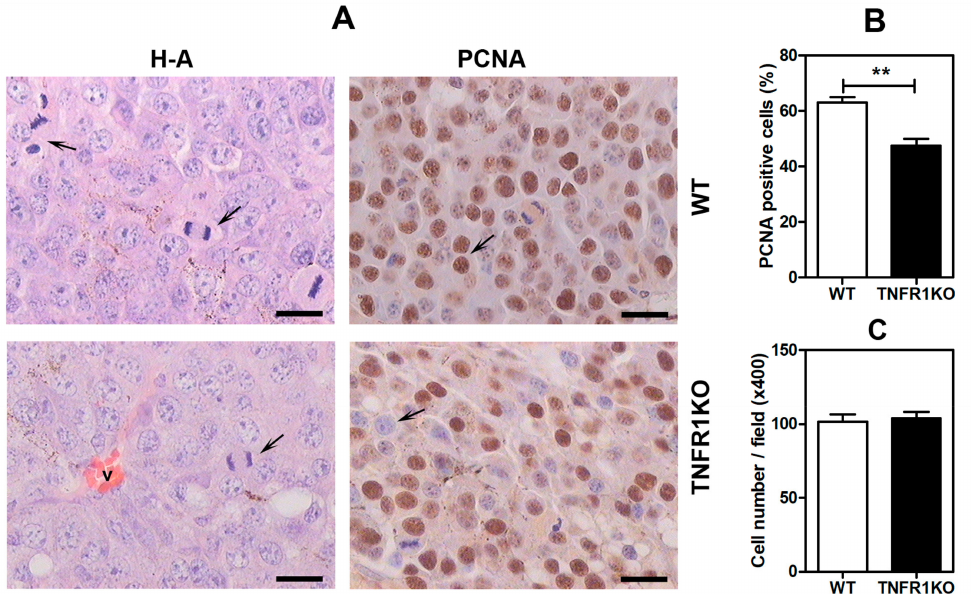
Figure 2. TNFR1 controls tumor proliferation in melanoma. Tumors in WT and TNFR1 KO mice were analyzed by immunohistochemistry to assess expression of proliferating cell nuclear antigen (PCNA), a marker of proliferating cells. ( A ) Hematoxylin & Eosin (H&E) and PCNA staining. The arrows on the H&E panels indicate mitotic cells, the arrows on the right panels indicate PCNA + (top) and PCNA − cells (below). The images are representative of three independent experiments. Scale bar: 25 µ m. ( B ) Quantification of PCNA + cells. Data are mean ± SEM ( n = 3). ( C ) Number of cell nuclei by field. Data are mean ± SEM ( n = 3), ** p <